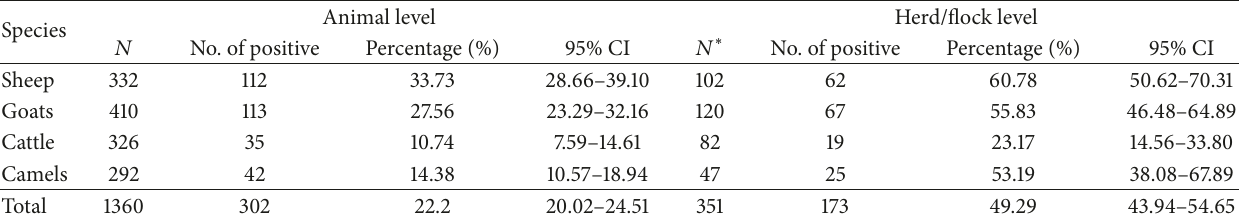
Table 1: Seroprevalence of T. gondii infection in domestic ruminants.